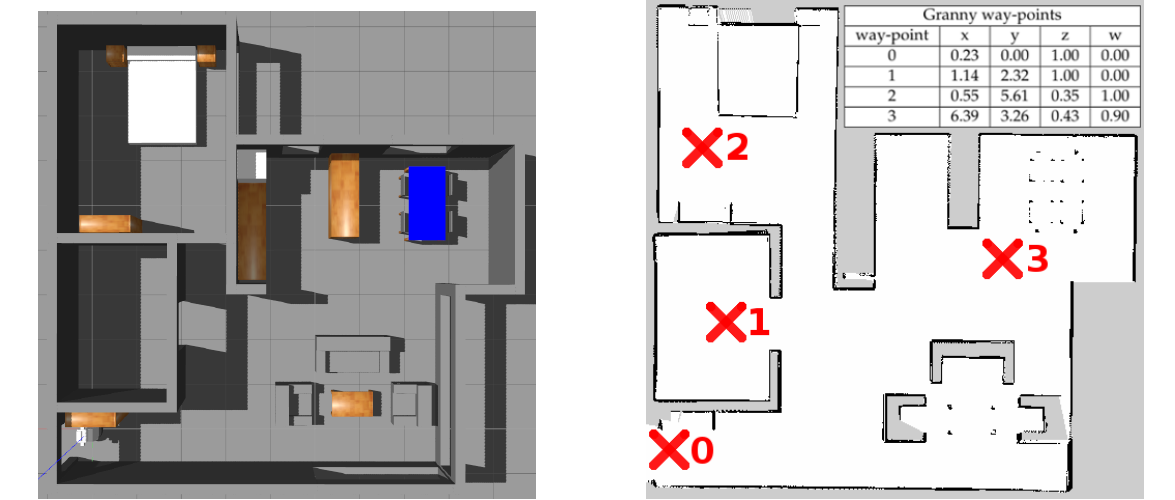
Figure 8. Gazebo zenith view and map deployed for the experimental